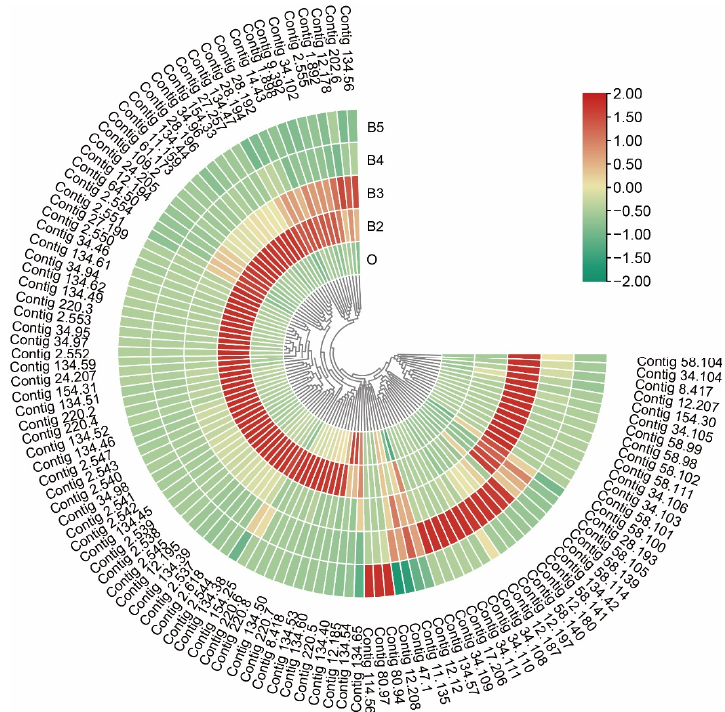
Figure 10. Expression profiles of cuticular protein genes, including the families encoding cuticle protein, larval cuticle protein, pupal cuticle protein, adult ‐ specific cuticular protein, and endocuticle structural glycoprotein. The color scale on the right shows the FPKM values for each developmental stage from red (high) to green (low), standardized by min–max normalization.